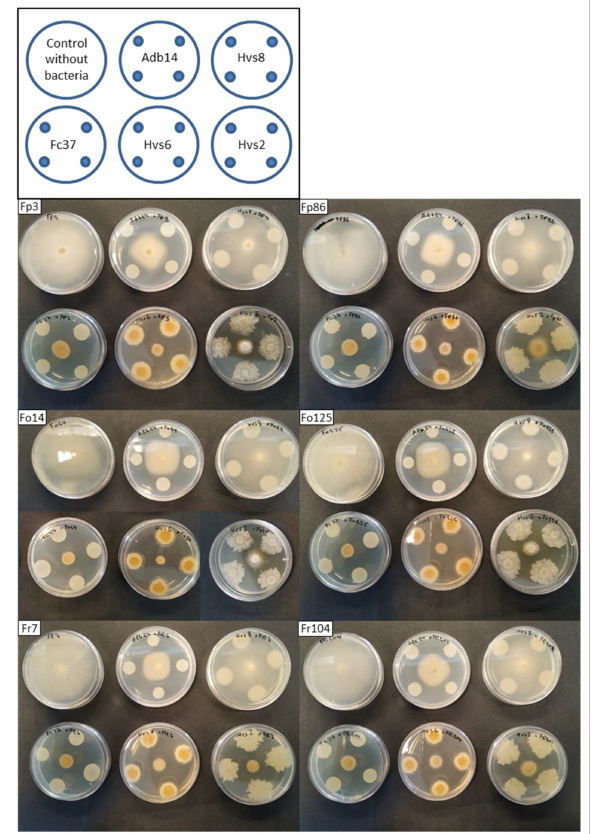
Figure 2. Dual confrontation experiments showing the inhibition of the fungal mycelial growth of Fusarium proliferatum (isolates Fp3 and Fp86), F. oxysporum f. sp. asparagi (isolates Fo14 and Fo125) and F. redolens (isolates Fr7 and Fr104) by the bacterial strains Adb14, Hvs8, FC37, Hvs6 and